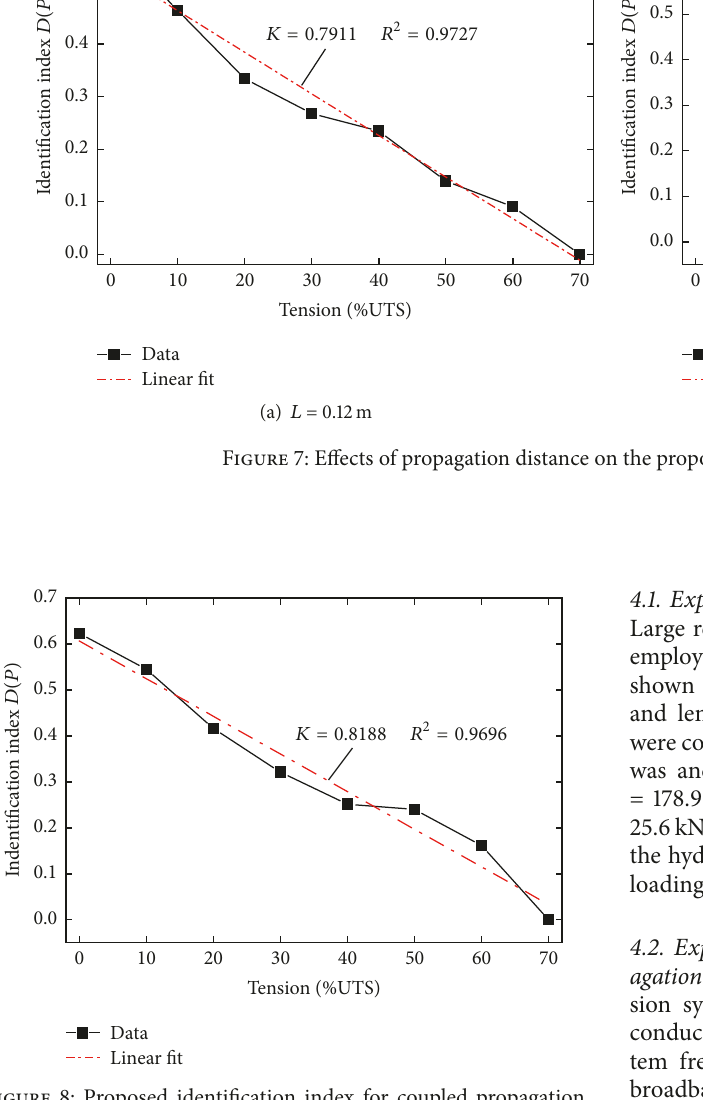
Figure 8: Proposed identification index for coupled propagation